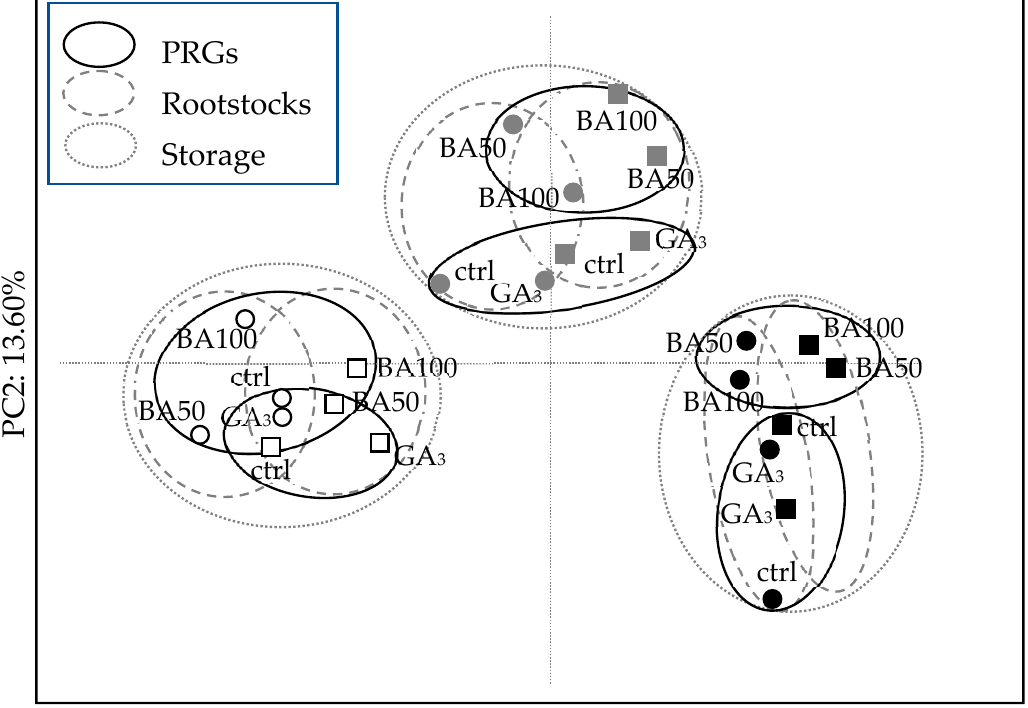
Figure 3. Principal component analysis: bi-plot of plum physicochemical properties with corresponding treatments. Legend: Rootstock: circles—“WaVit”, squares— P. cerasifera / P. spinosa . Storage duration: —at harvest; —after 28 days of cold storage; —after 4 days of shelf life. Treatments: ctrl—control; GA 3 —200 mg L − 1 of gibberellin A3, BA50—50 mg L − 1 of 6-benzyladenine, BA100—100 mg L − 1 of 6-benzyladenine.